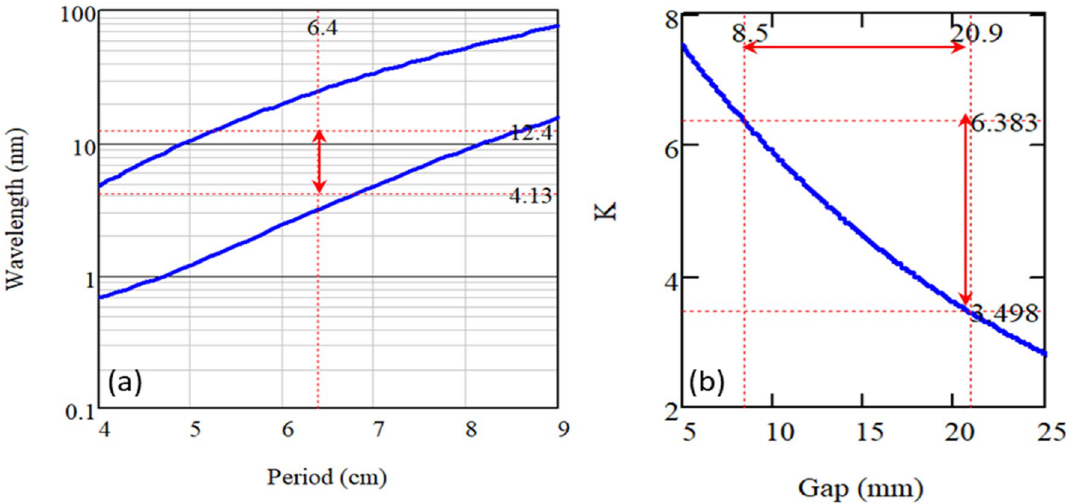
Figure 3. For the radiator with the period of 6.4 cm and the maximum B field of 0.90 T, the gap can be varied in the range of the minimum 6 mm to the maximum 50 mm. ( a ) (left) Wavelength versus undulator period is plotted with the minimum gap (upper blue line) and the maximum gap (lower blue line). The wavelength in the range of [4.13 12.4] nm determines the optimum period of 6.4 cm. ( b ) (right) Modulator K parameter versus gap. The radiation wavelengths ([4.13 12.4]) nm corresponds to the gap between 20.9 and 8.5 mm and the K parameter between 3.5 and